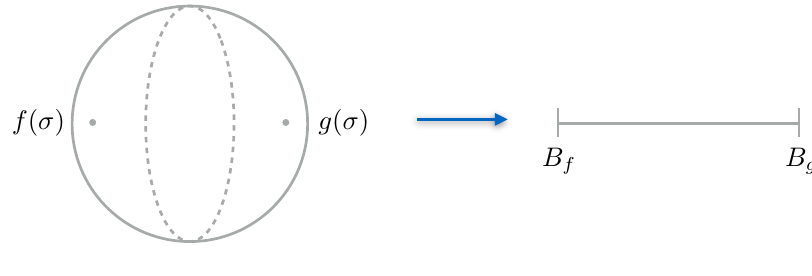
Figure 13. Quantum Mechanics